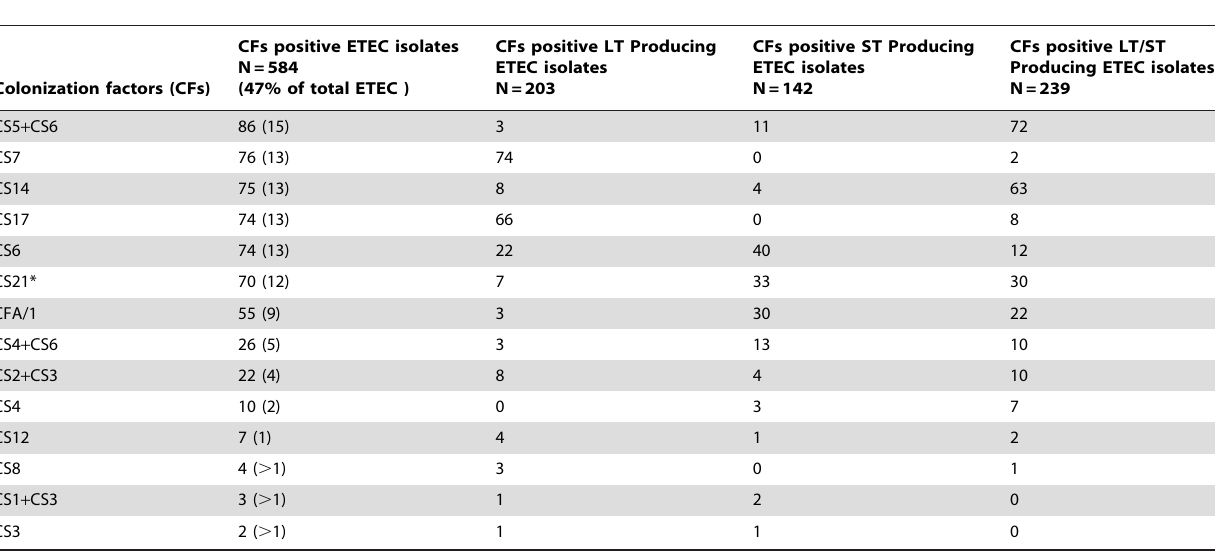
Table 3. Expression pattern of colonization factors for ETEC toxin type (March 2008 and February